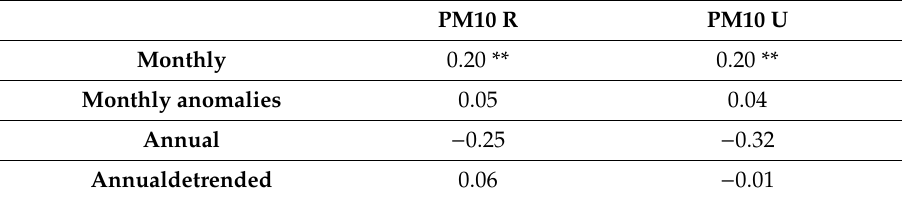
Table 6. "Annual detrended" indicates the correlation between the time annual detrended time series. PM10 R PM10 U